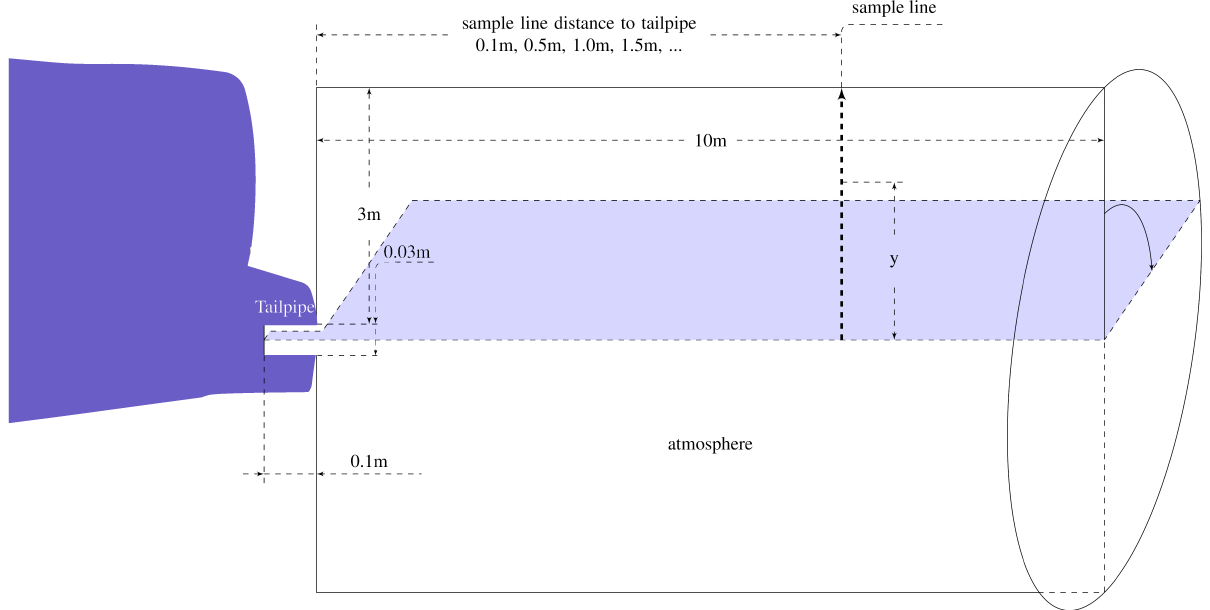
Figure 1. Flow field of